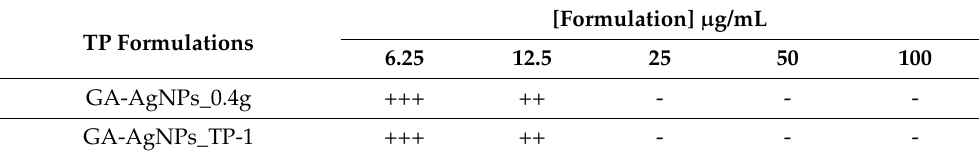
Table 4. Effect of GA-AgNPs_0.4g and GA-AgNPs_TP-1 using spot-plating assay. TP Formulations